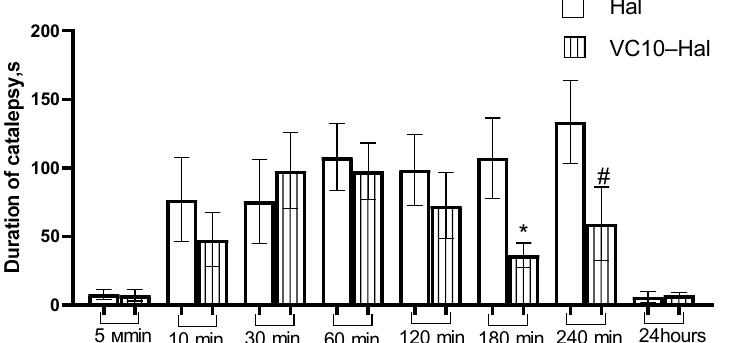
Figure 8. Duration of catalepsy after intranasal administration (s). * p < 0.05—Statistically significant difference compared to the haloperidol group. # 0.05 < p < 0.1—Significance trend compared to haloperidol group.